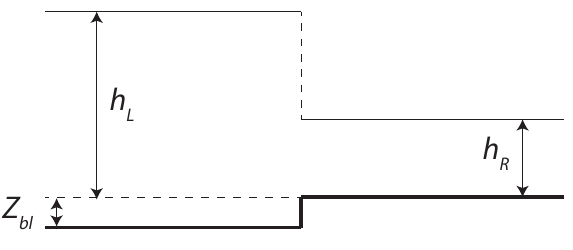
Fig. 2. Scheme of the parameters used in the validation test.